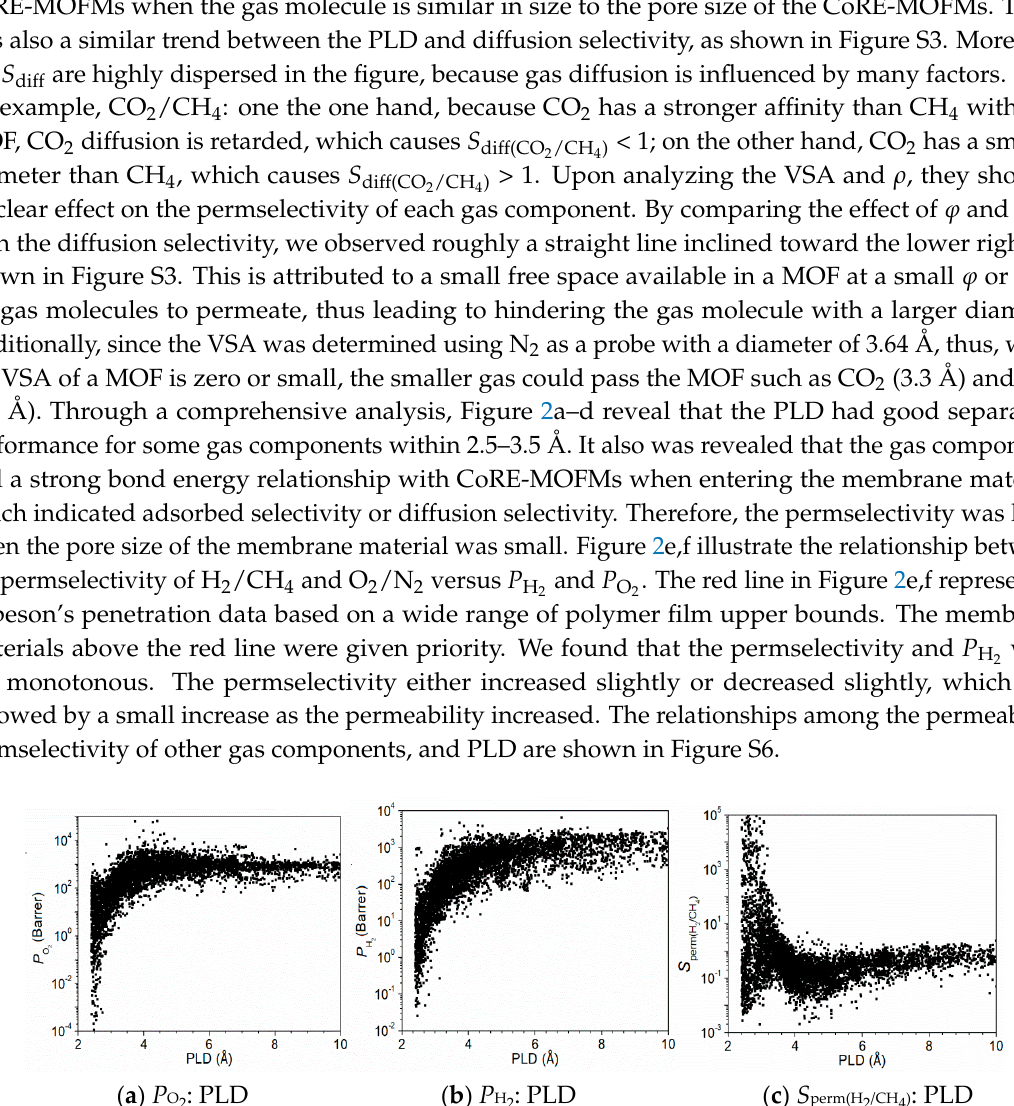
and P H and ( f ) 2 2 /CH 4 )